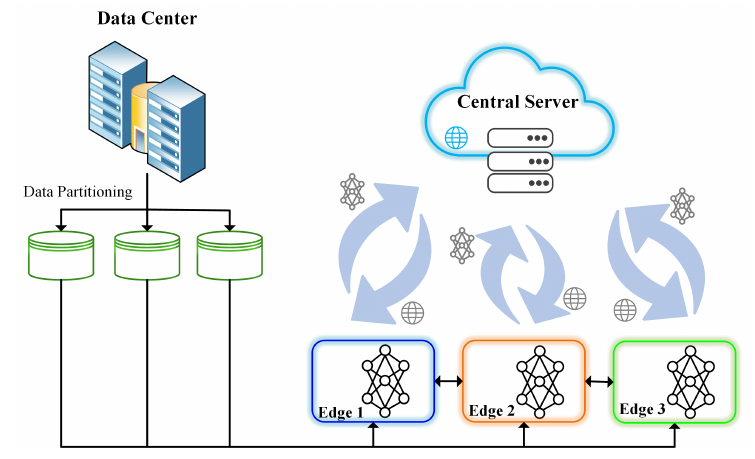
Figure 1. Distributed learning